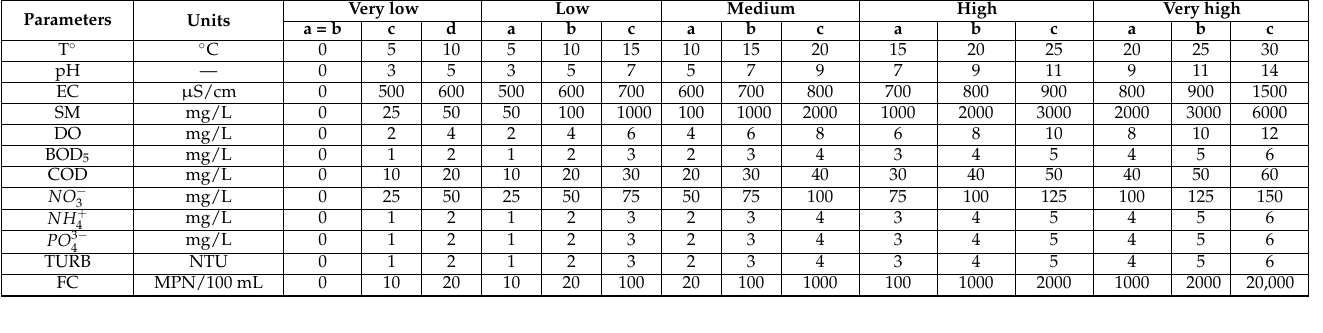
Table 8. Linguistic terms and fuzzy sets for the fuzzy index.